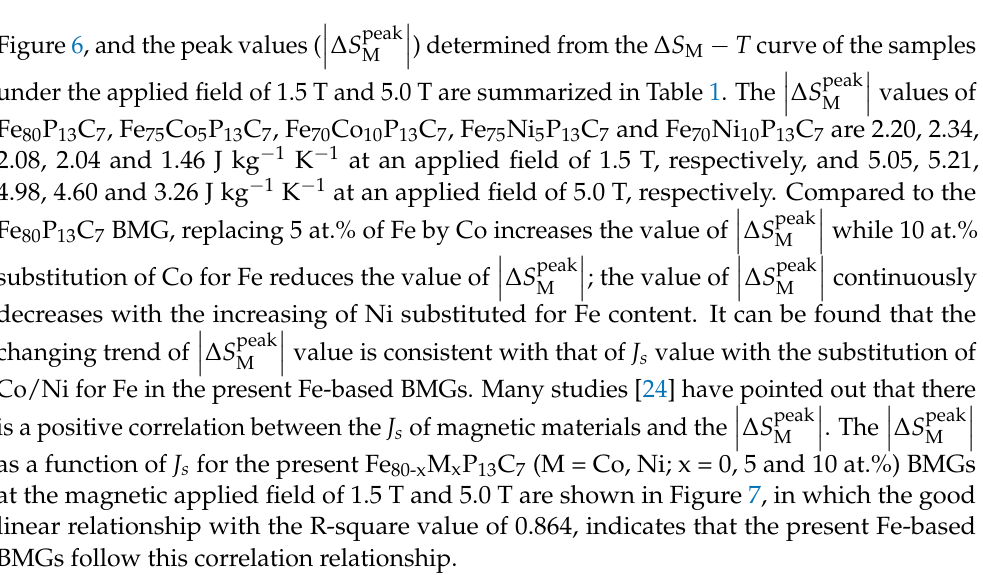
(cid:12) (cid:12) ∆ S peak (cid:12) (cid:12) (cid:12) ) determined from the (cid:12) M